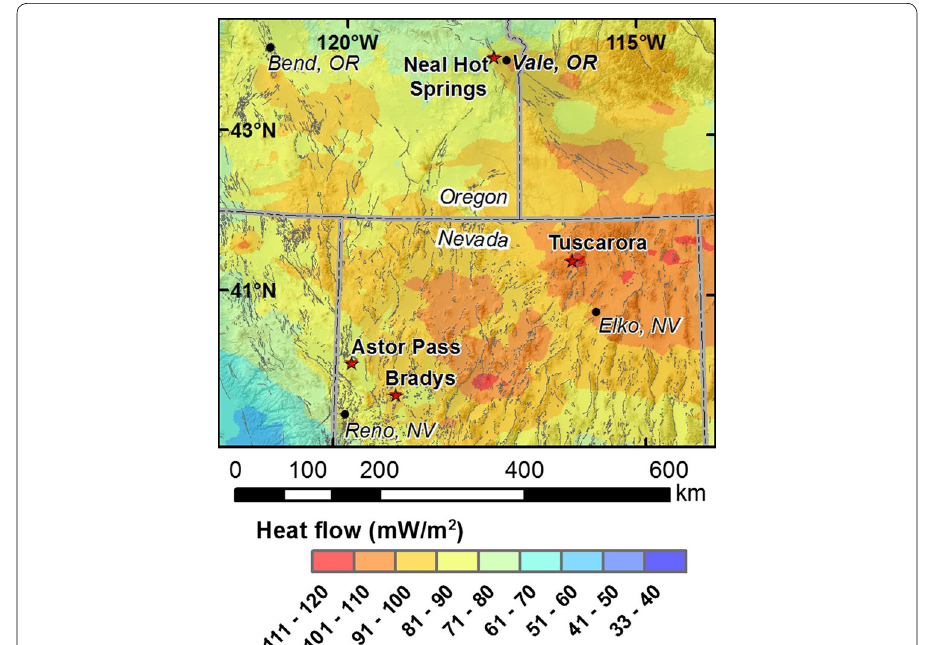
Fig. 1 Regional heat flow map showing the locations of the Astor Pass, Nevada; Bradys, Nevada; Neal Hot Springs, Oregon; and Tuscarora, Nevada geothermal systems that are referenced in this study. Modeled heat flow data from Williams and DeAngelo (2011). Faults from the U.S. Geological Survey Quaternary Fault and Fold Database (U.S. Geological Survey